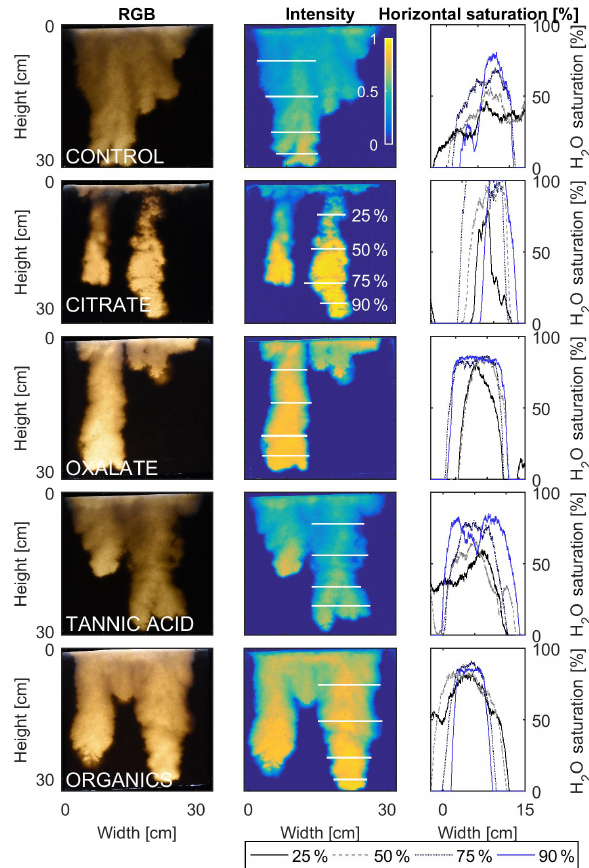
Figure 11. Multigraph comparison of the finger width profiles of infiltration of water in US Silica C778 ASTM graded sand for con- trol (NaCl + HNS), and low concentrations of plant exudates (cit- rate and oxalate) and soil components (tannic acid and organics: Suwanee River natural organic matter, SRNOM). The images are of the main finger at its full length. The location of the horizontal water saturation profile analyses and widths are measured at 25, 50, 75, and 90% of the total fingers length.